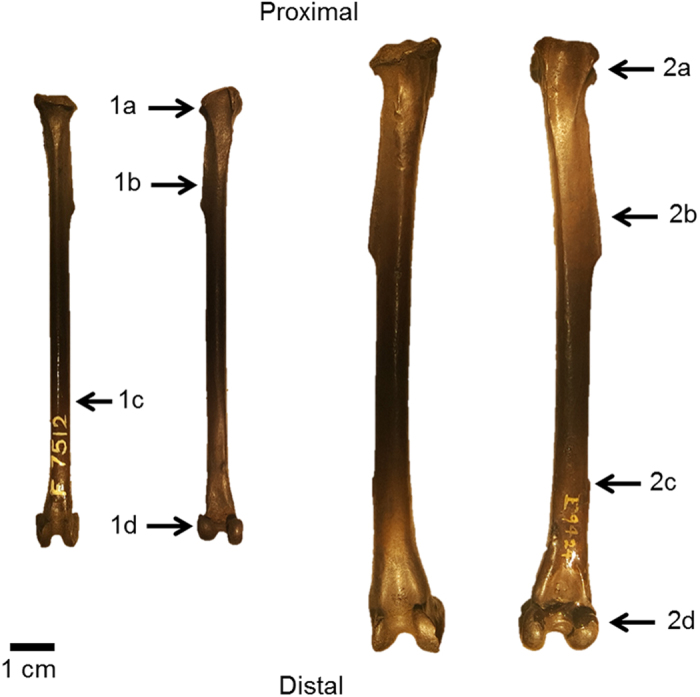
Tyto alba (1a–d) and Bubo virginianus (2a–d) tibiotarsus morphology. Anterior view on right and posterior view on left for each specimen. (1a) Moderately developed cnemial crests; (1b) Slight fibular crest; (1c) Fibula free of shaft; (1d) Distal condyles of nearly equal size. (2a) Moderately developed cnemial crests; (2b) Moderately developed fibular crest; (2c) Fibula fused distally to shaft; (2d) Distal condyles of nearly equal size.